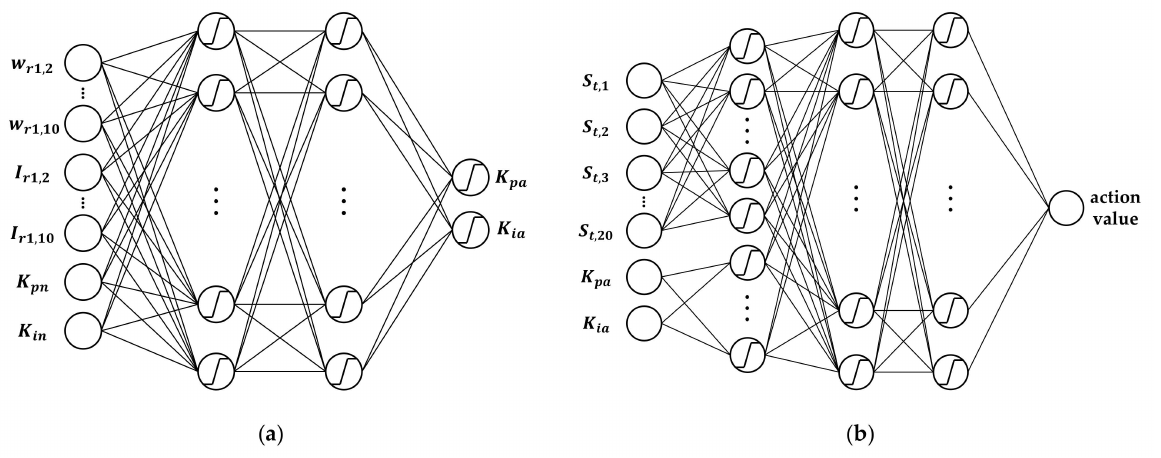
Figure 7. Architectures of the networks: ( a ) actor and ( b ) critic.